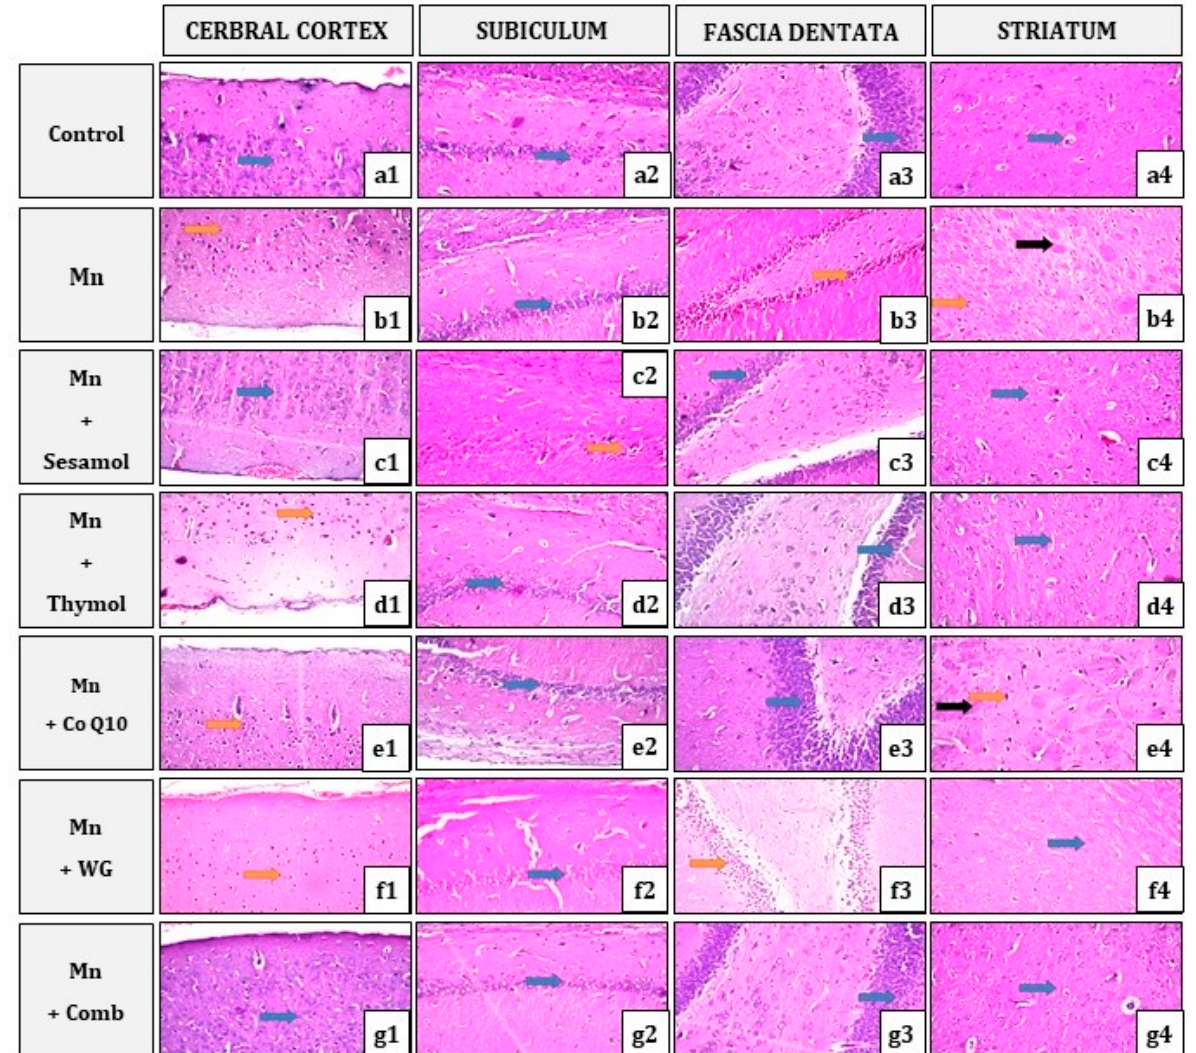
Figure 9. Photomicrographs of brain sections (cerebral cortex, subiculum and fascia dentata in hippocampus, and striatum areas) stained by Hematoxylin and Eosin (magnification power of 40×). Where: ( a1 – a4 ): control group, ( b1 – b4 ): Mn group, ( c1 – c4 ): Mn + Sesamol group, ( d1 – d4 ): Mn + Thy- mol group, ( e1 – e4 ): Mn + CoQ10 group, ( f1 – f4 ): Mn + WG group, and ( g1 – g4 ): Mn + Combination of Sesamol + Thymol + CoQ10 + WG. Where: ( blue arrow ) indicates no histopathological alteration, ( orange arrow ) indicates nuclear pyknosis and degeneration, and ( black arrow ) indicates focal eo- sinophilic plagues.